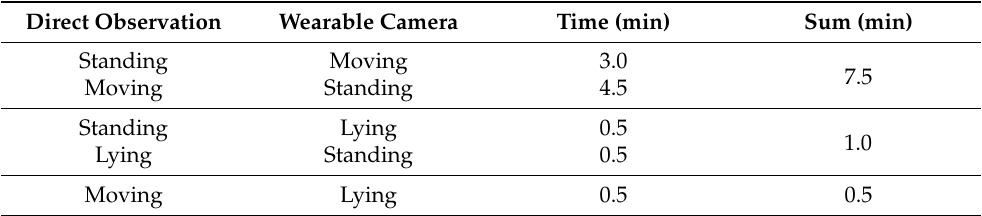
Table 7. Differences in the time recorded for different postures based on direct and wearable camera observations during the study investigating the suitability of wearable cameras for monitoring juvenile bovine